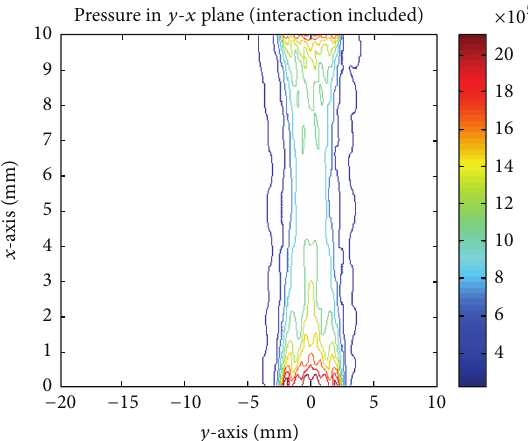
Figure 13: Acoustic pressure in the 𝑥 - 𝑦 plane when the interaction effect is